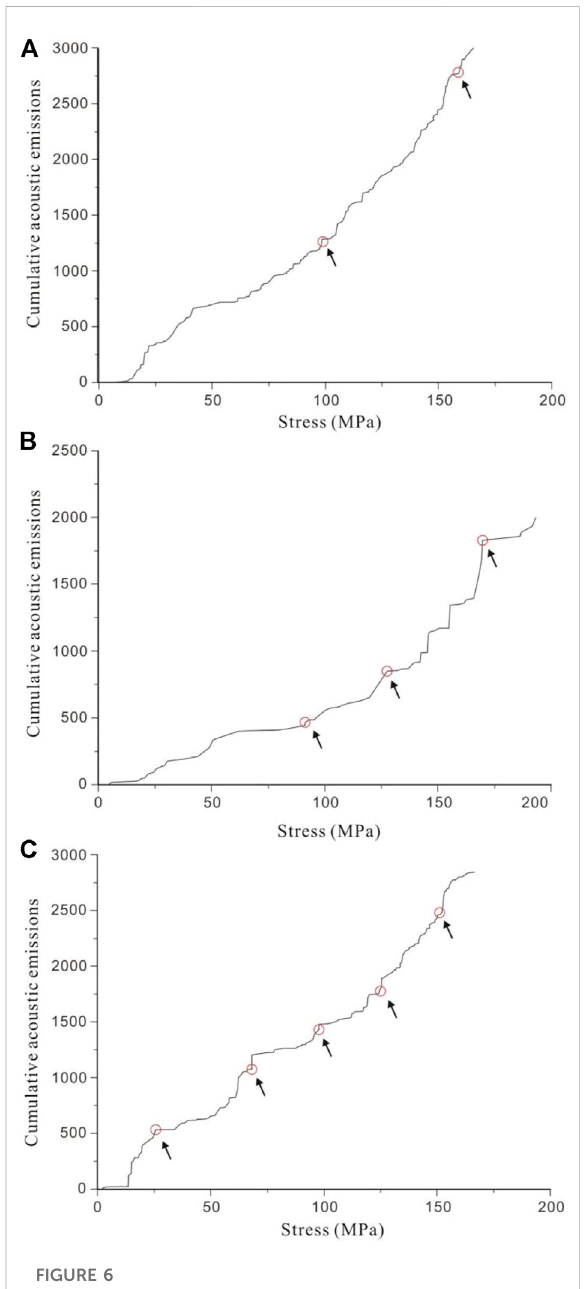
FIGURE 6 Acoustic emission experimental curves of shale samples (The sampling location is shown in Figure 1; (A) : Sample No. 1-1, Cretaceous sample; (B) : Sample No. 1-4, Jurassic sample; (C) : Sample No. 1-6, Triassic